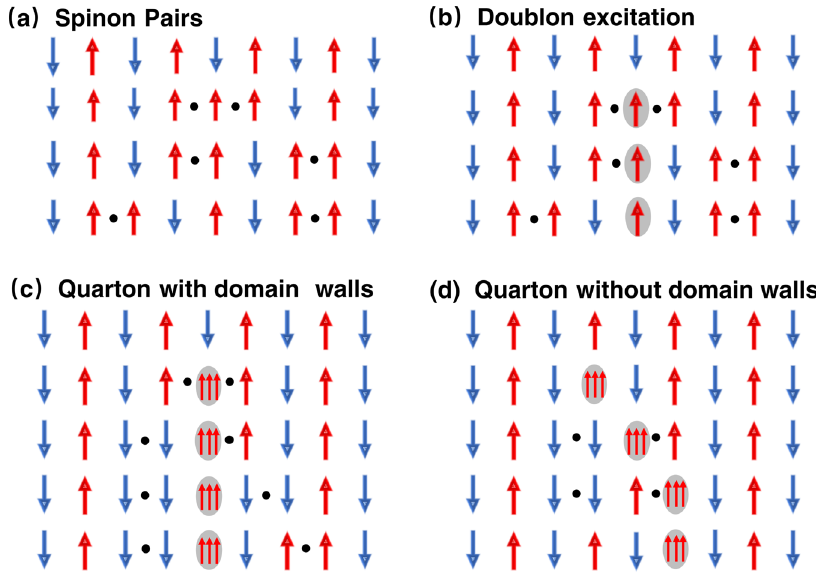
Fig. 9 Schematic illustrations of propagating doublons and quartons. In each case a – d , the excitation mechanism and propagation of a quasiparticle are illustrated from top to bottom. a The conventional simpli fi ed description of spinons in the HAC, where the dots indicate domain walls between the two realizations of the antiferromagnetic spin state, and these domain walls can move as a result of fl ips of a pair of neighboring spins. b A doublon excitation, where the trimer in the excited state is indicated by the gray shading. The spinons (domain walls indicated by dots) should be bound to the excited triplet and can be created and destroyed by vacuum fl uctuations. Quartons with ( c ) and without ( d ) domain walls for ∣ Δ M ∣ = 1 ( S =